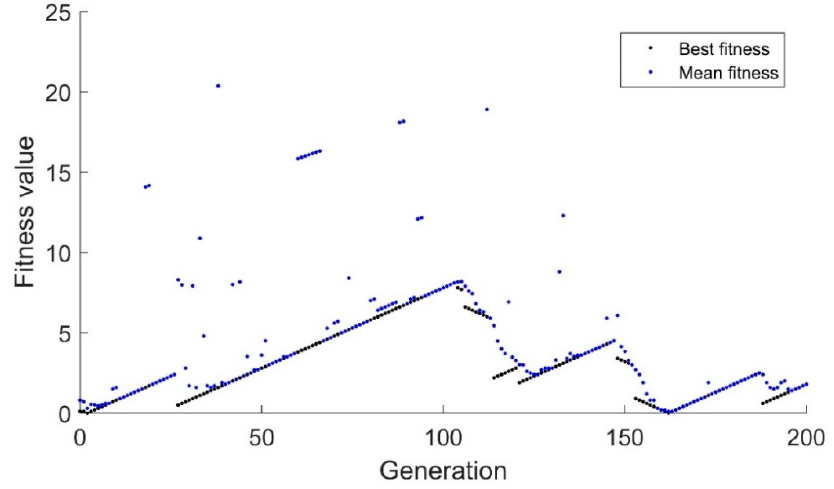
Figure 1. A binary genetic algorithm responding to a moving goal after initial convergence.